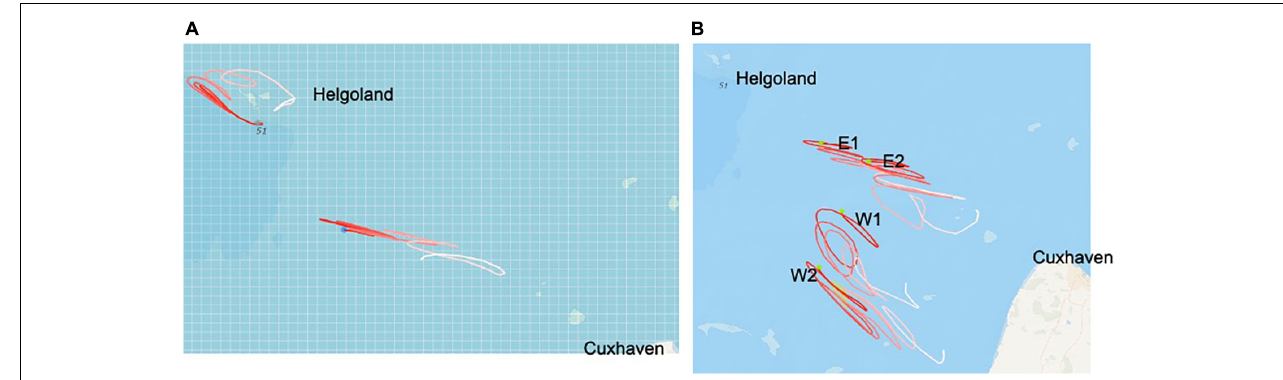
FIGURE 4 | Three day back-trajectories of water mass for (A) two stations near Helgoland and (B) two stations north-west (E1, E2) and west (W1, W2) of Cuxhaven. Green dots indicate the starting position and starting time of the water mass. Red color depicts the starting time, white color depicts the position 3 days before. For a better orientation the island of Helgoland is indicated and the port of Cuxhaven.